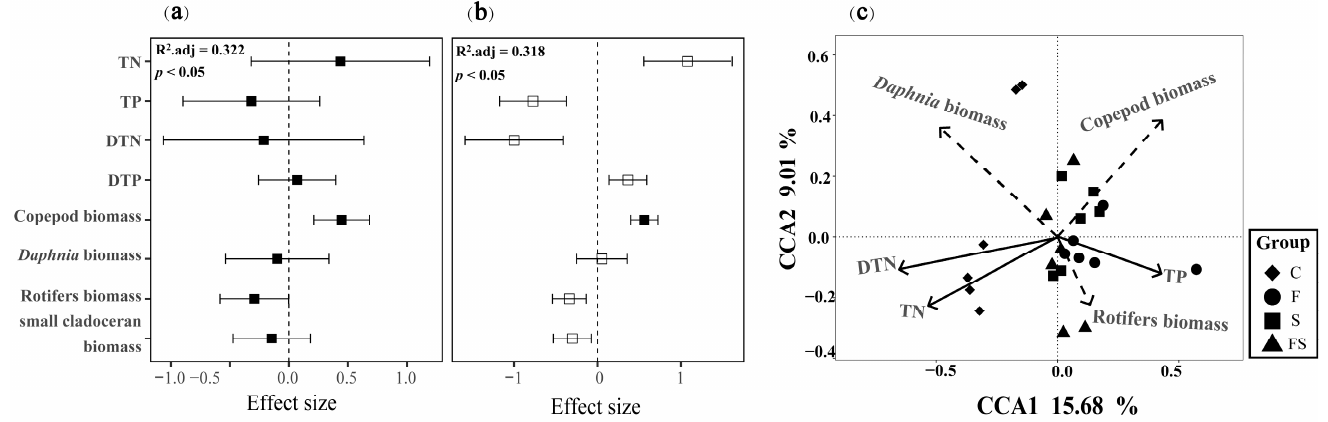
Figure 5. The outcome of a multiple linear regression in terms of the effects of predictor variables on the number of ASVs ( a ) and phylogenetic index diversity ( b ) (black solid lines indicate the mean ± SE, p < 0.05). Redundancy analysis of environmental indicators and biological factors in water bodies and changes in the composition of phytoplankton communities in the treatments ( c ) (solid black arrows indicate environmental indicators and dotted black arrows indicate biological factors. Shapes represent treatments).